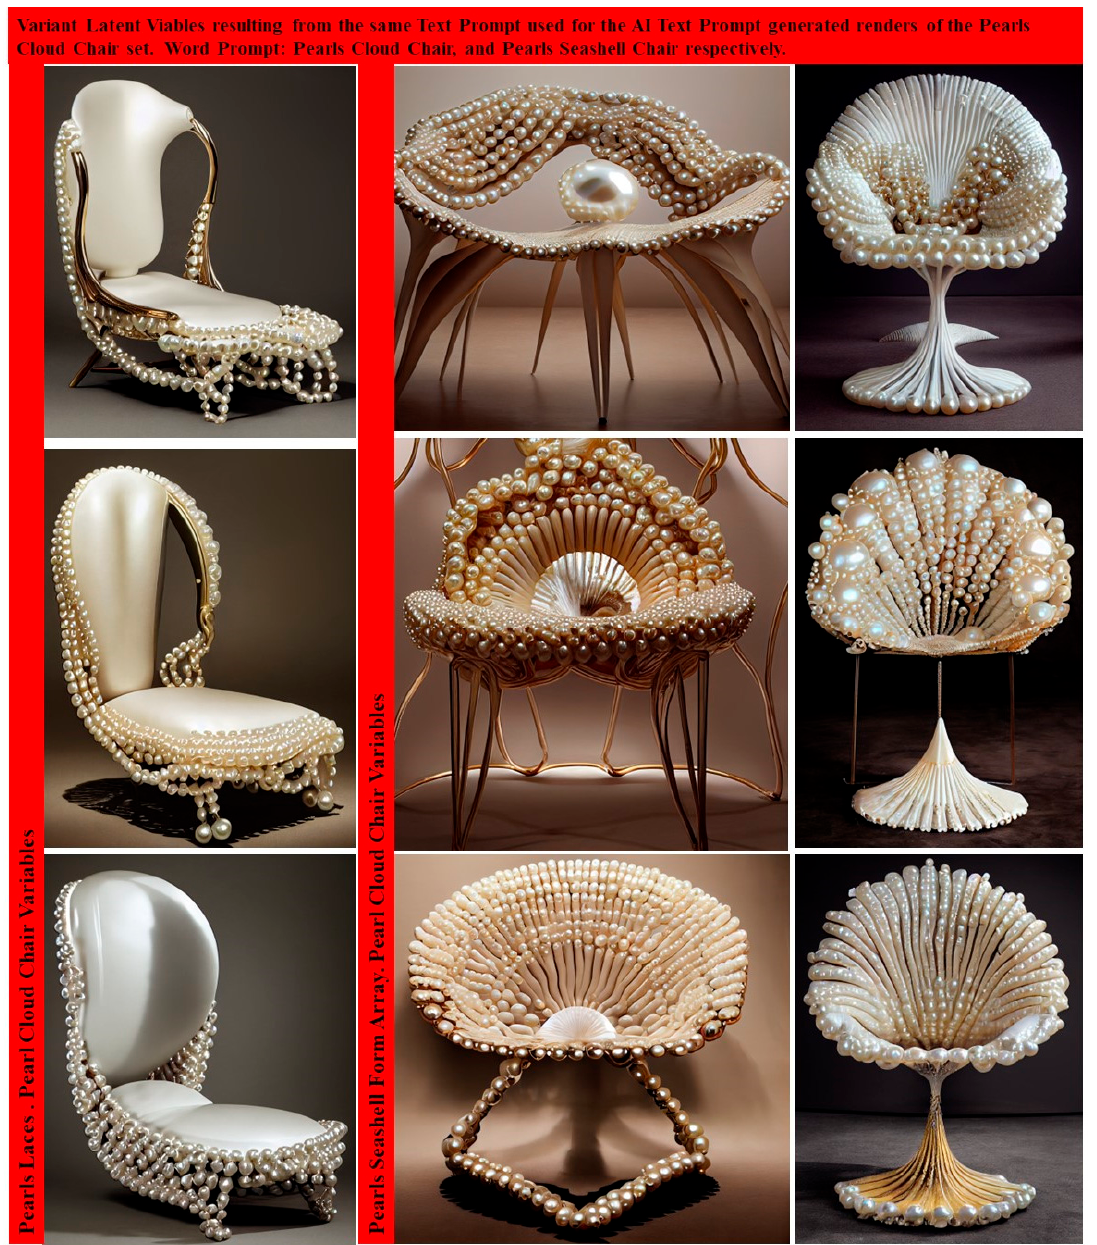
Figure 5. The pearl cloud chair seashell-based biocomposite material from food waste: the limited formal categories of latent variables generated by the AI image generator Midjourney.